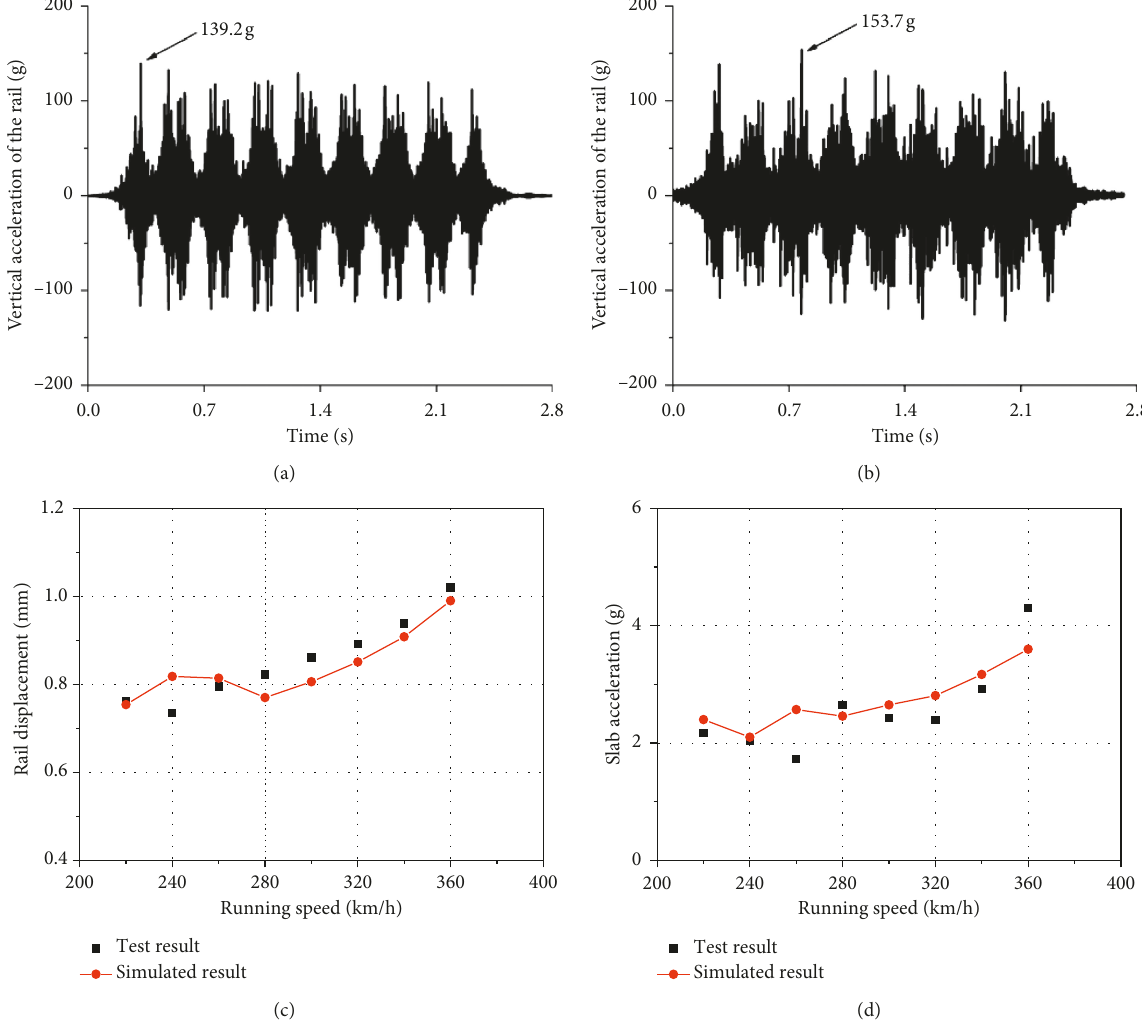
Figure 6: Comparison between test results and simulated results: (a) calculated rail acceleration, (b) measured rail acceleration, (c) comparison of rail displacement, and (d) comparison of slab